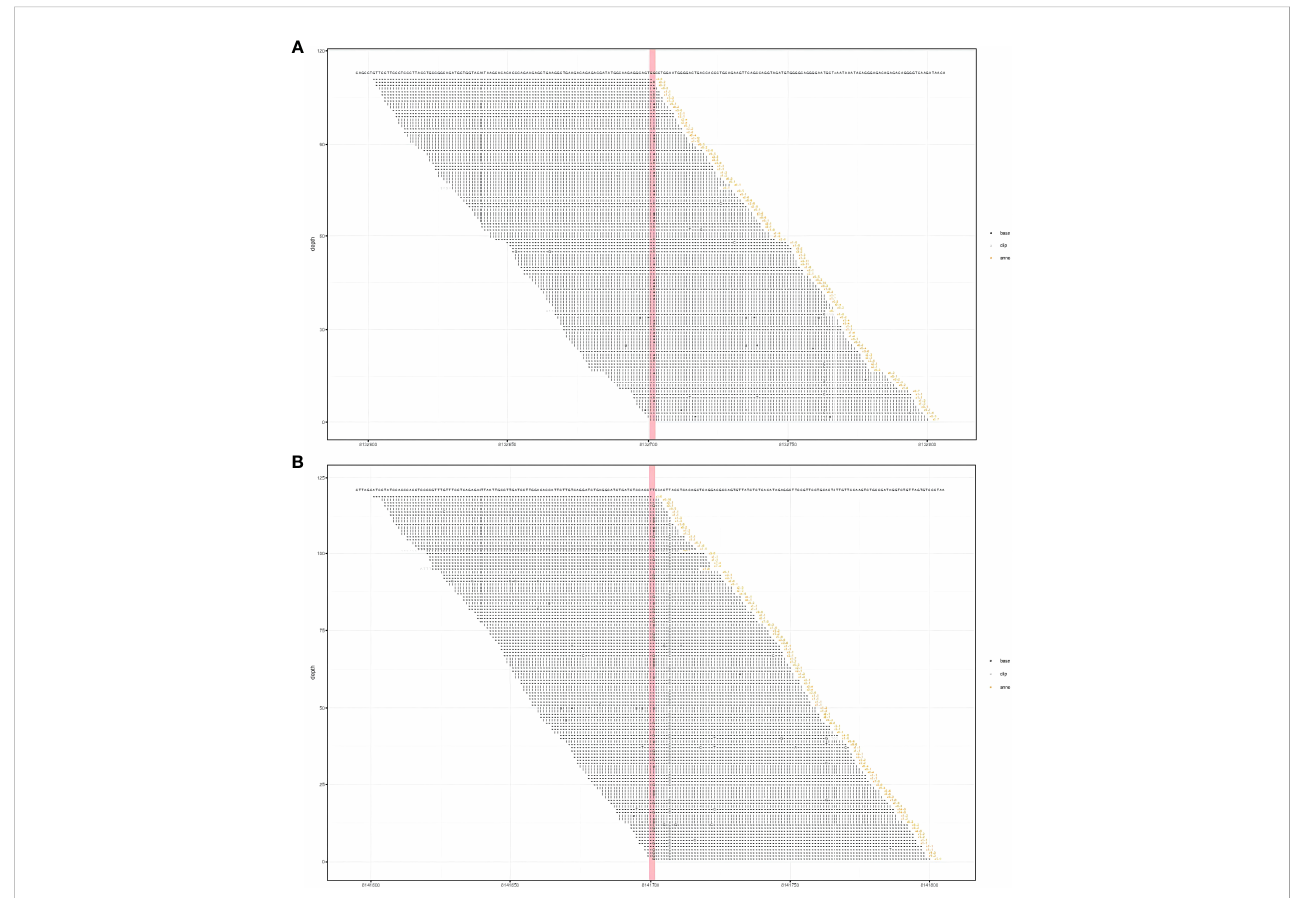
FIGURE 2 Results of whole exome sequencing showed compound heterozygous variants in the CTC1 gene with a c.3074C>T (p.Ala1025Val) mutation (exon 19) (A) and a c.435+9A>C mutation (IVS3) (B) . (A) CTC1 NM_025099.5 exon 19 c.3074C>T (p.Ala1025Val). (B) CTC1 NM_025099.5 IVS3